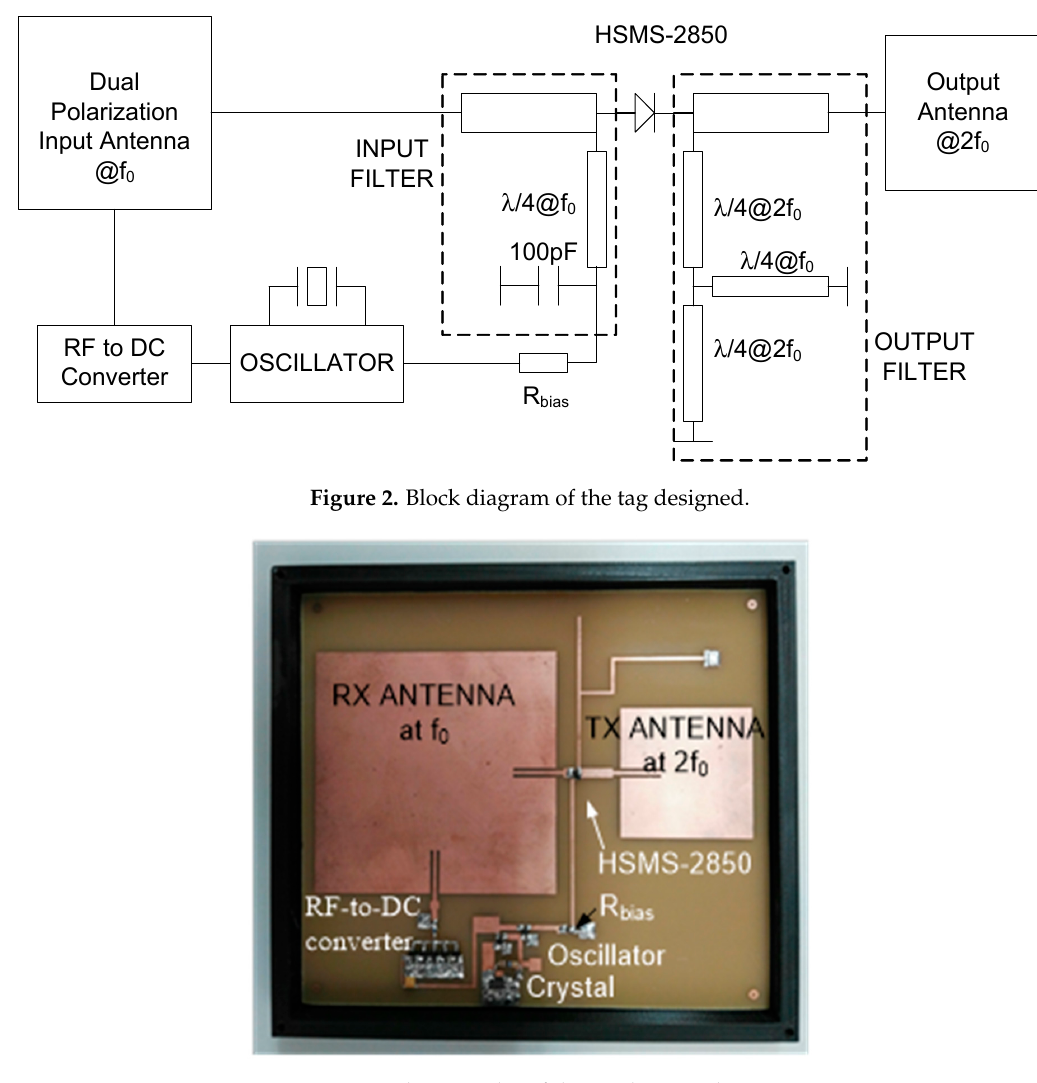
Figure 3. Photography of the implemented tag.